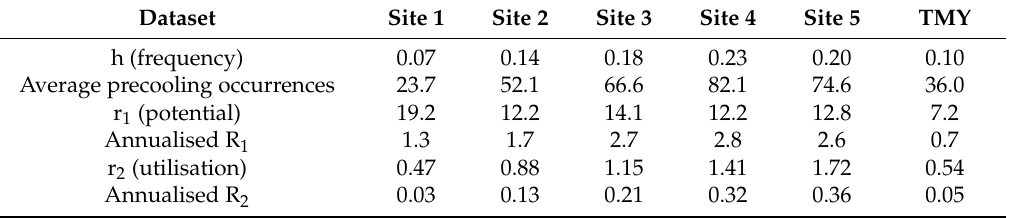
Table 5. Summary of precooling potential and utilisation across the five sites in